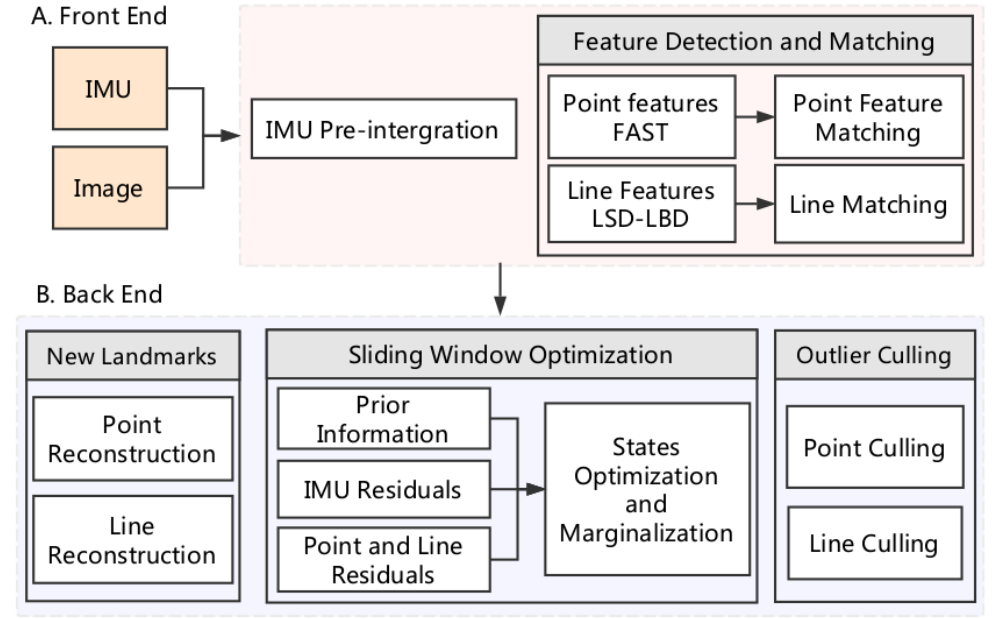
Figure 4. Overview of our point–line visual–inertial odometry (PL-VIO) system. A is the front end module is used to extract information from the raw measurements; B is the back end module is used to estimate and optimize the body